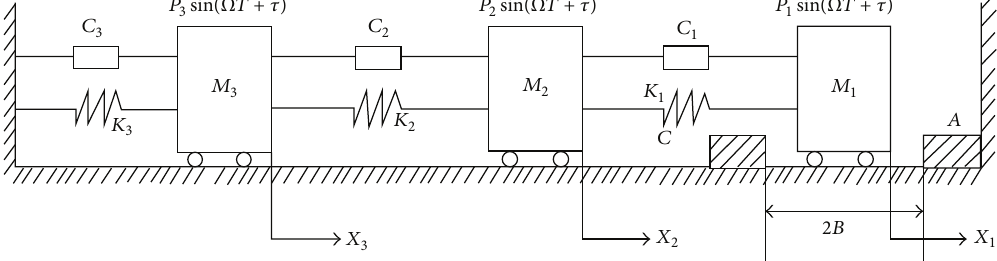
Figure 1: Schematic of the there-degree-of-freedom impact oscillator with symmetrical constraints.